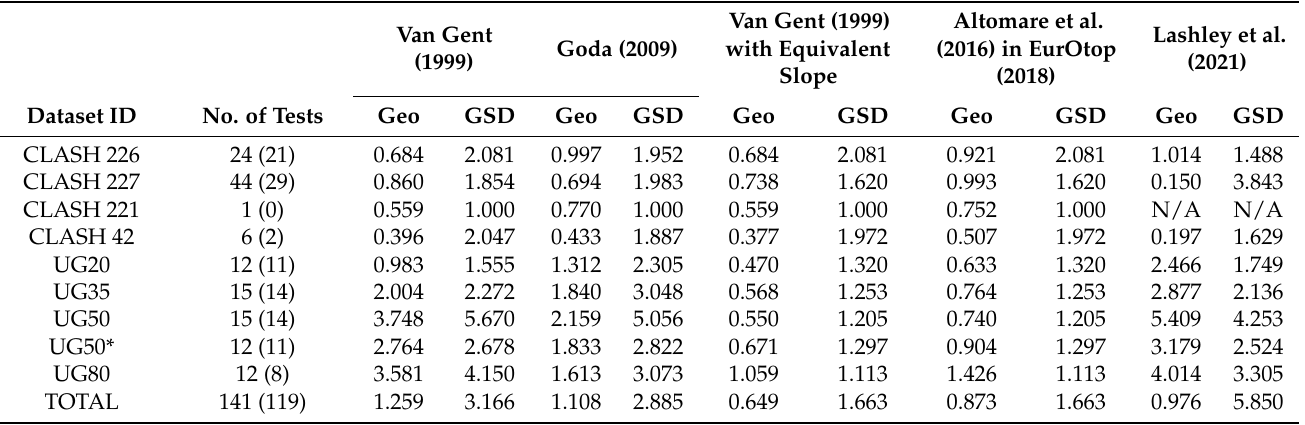
Table 4. Results of prediction performance of existing empirical formulas related to wave overtopping at a dike on shallow foreshores. In the No. of tests, the number between parentheses is the amount of tests that fall within the applicability range of Lashley et al.